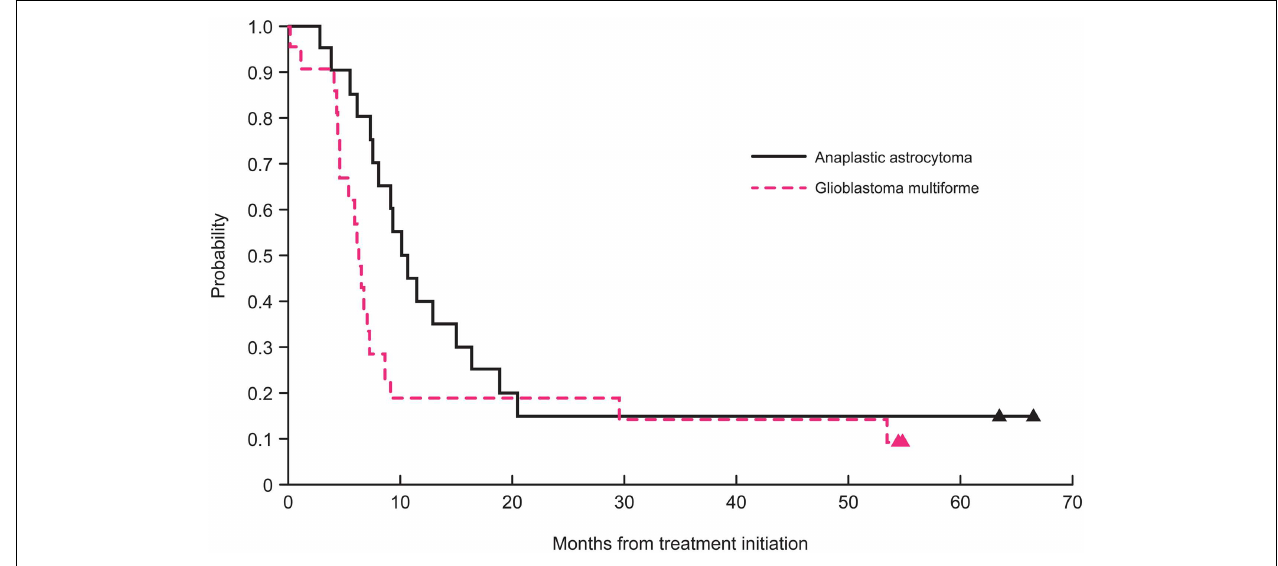
FIGURE 1 |Two-year progression-free survival curves for patients with glioblastoma and anaplastic astrocytoma